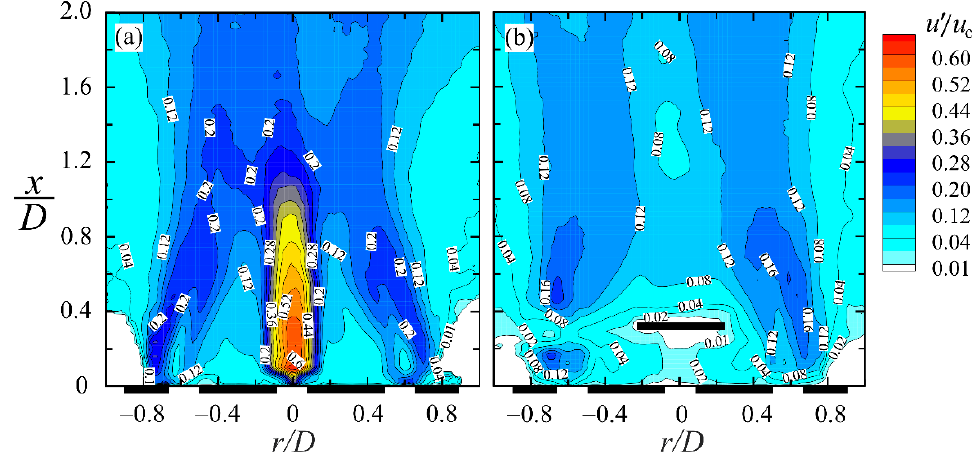
Figure 5. Axial fluctuation velocity contours of swirling double-concentric jets. Re c = 280, Re a = 480, and S = 0.432. ( a ) One centerbody, ( b ) two centerbodies.